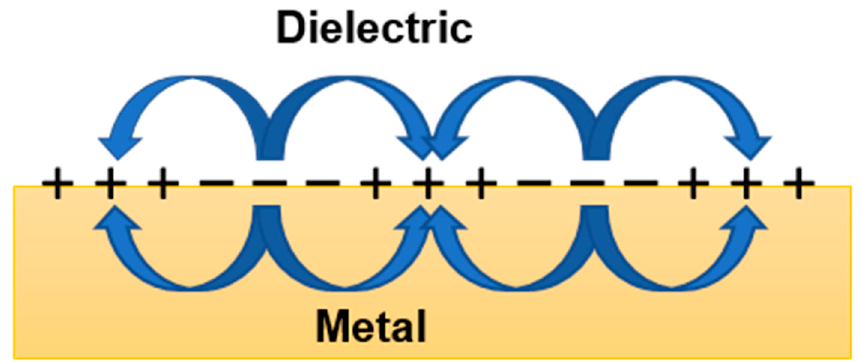
Figure 2. Schematic illustration of surface plasmons propagating at the interface between metal and dielectric [38].